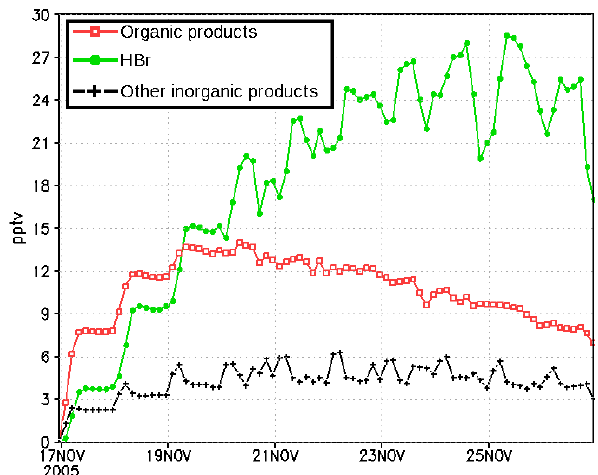
Figure 2: Time evolution of the BrWMR for bromoform (black), in product gases (red) and in the Fig. 2. Time evolution of the BrWMR for bromoform (black), in sum (green) over the 10 days of the BG1 simulation at 1 km altitude 12.4° S and 130.°9 W product gases (red) and in the sum (green) over the 10 days of (middle point of the domain). the BG1 simulation at 1km altitude 12.4 ◦ S and 130.9 ◦ W (middle point of the domain).